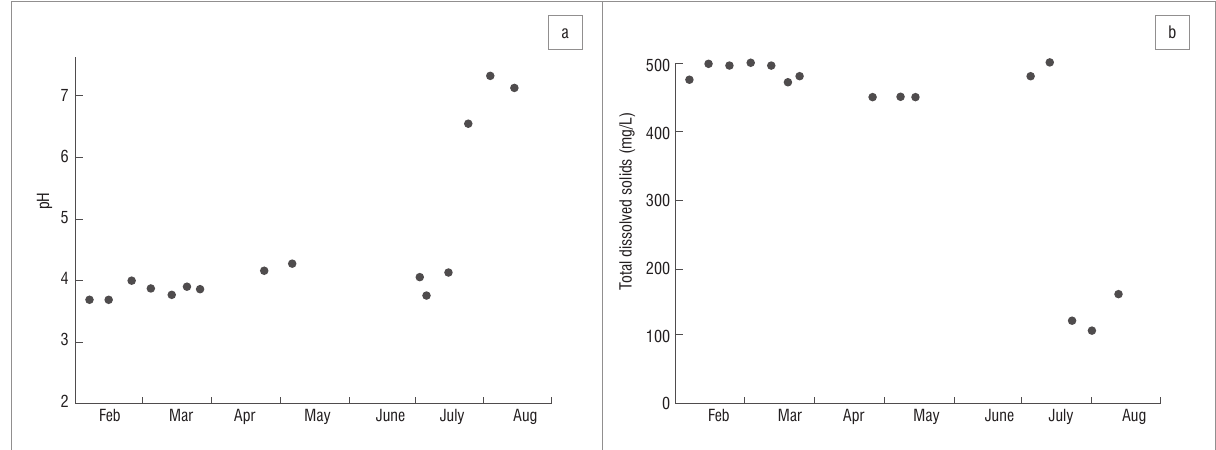
Figure 2: The (a) pH and (b) concentration of total dissolved solids of Boesmanspruit Dam over the period from February to August